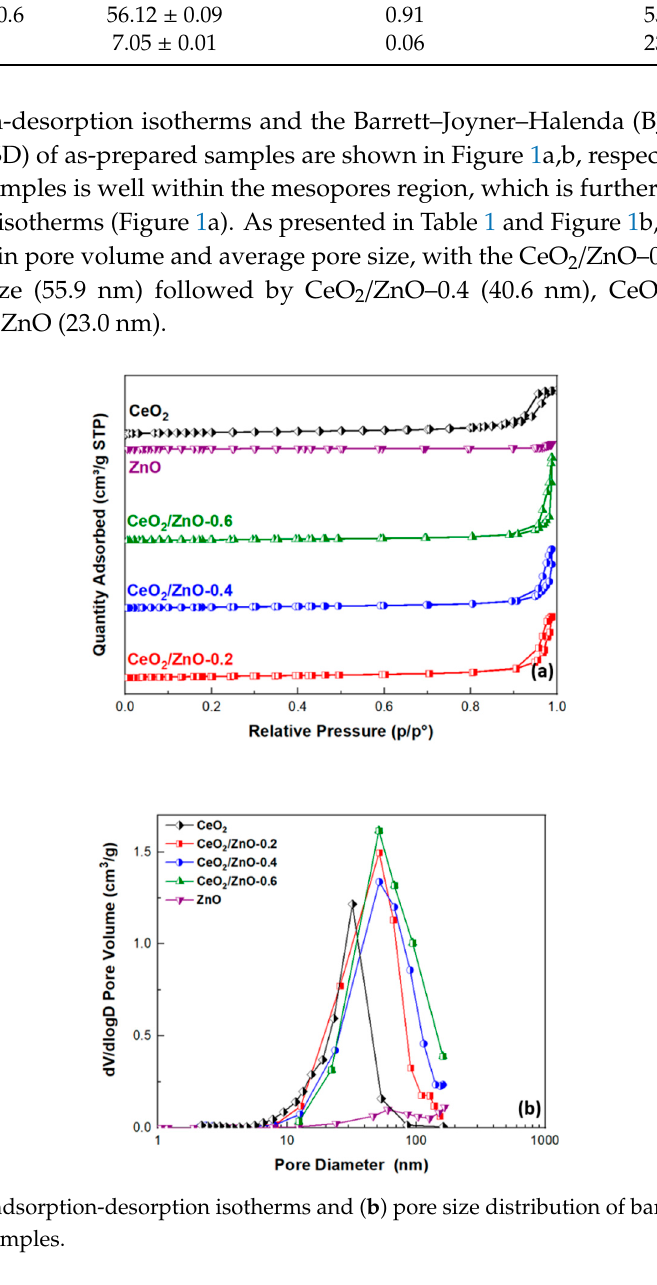
Table 1. Textural characteristics of bare CeO 2 , ZnO and the CeO 2 / ZnO samples.